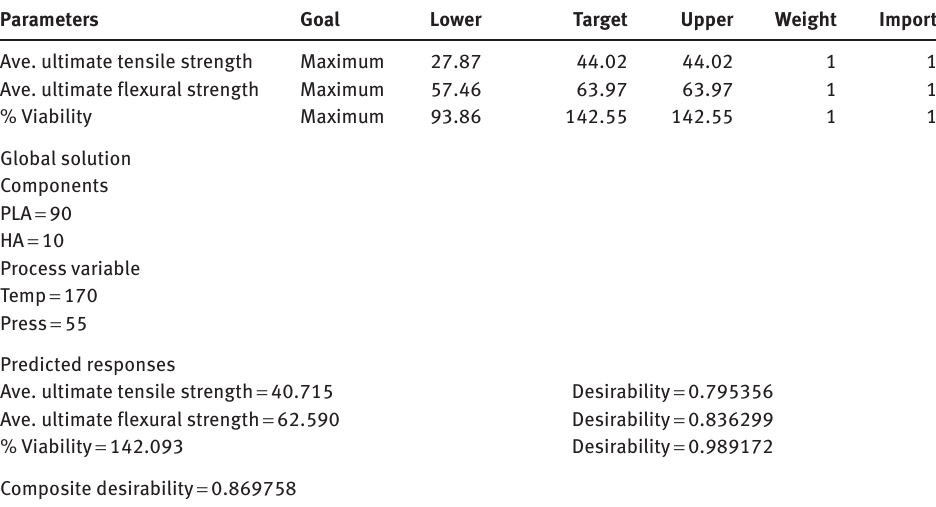
Table 13: Response optimization of HA-PLA composite.